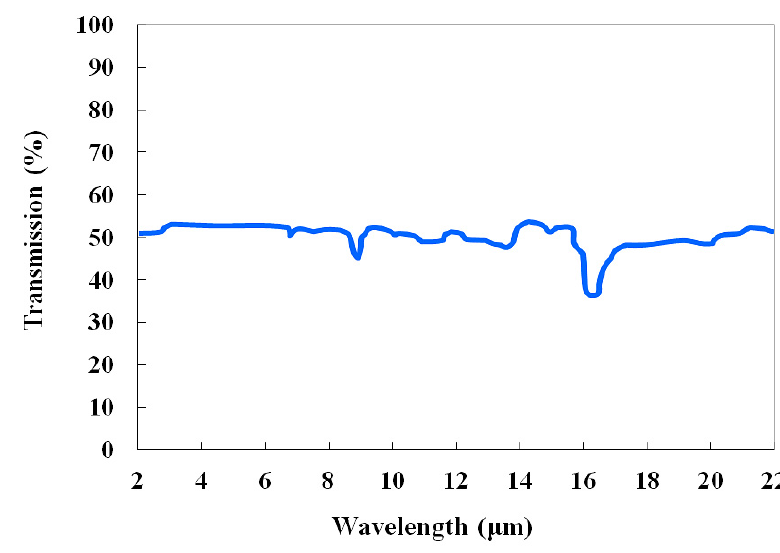
Figure 5. Transmission rates of an IR filter on the thermopile